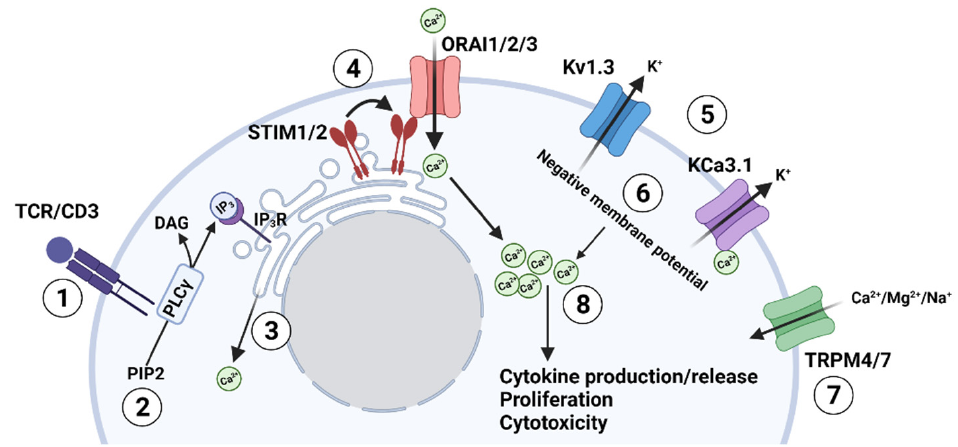
Figure 1. TCR-mediated regulation of the ion channel network in T lymphocytes. (1) Antigen